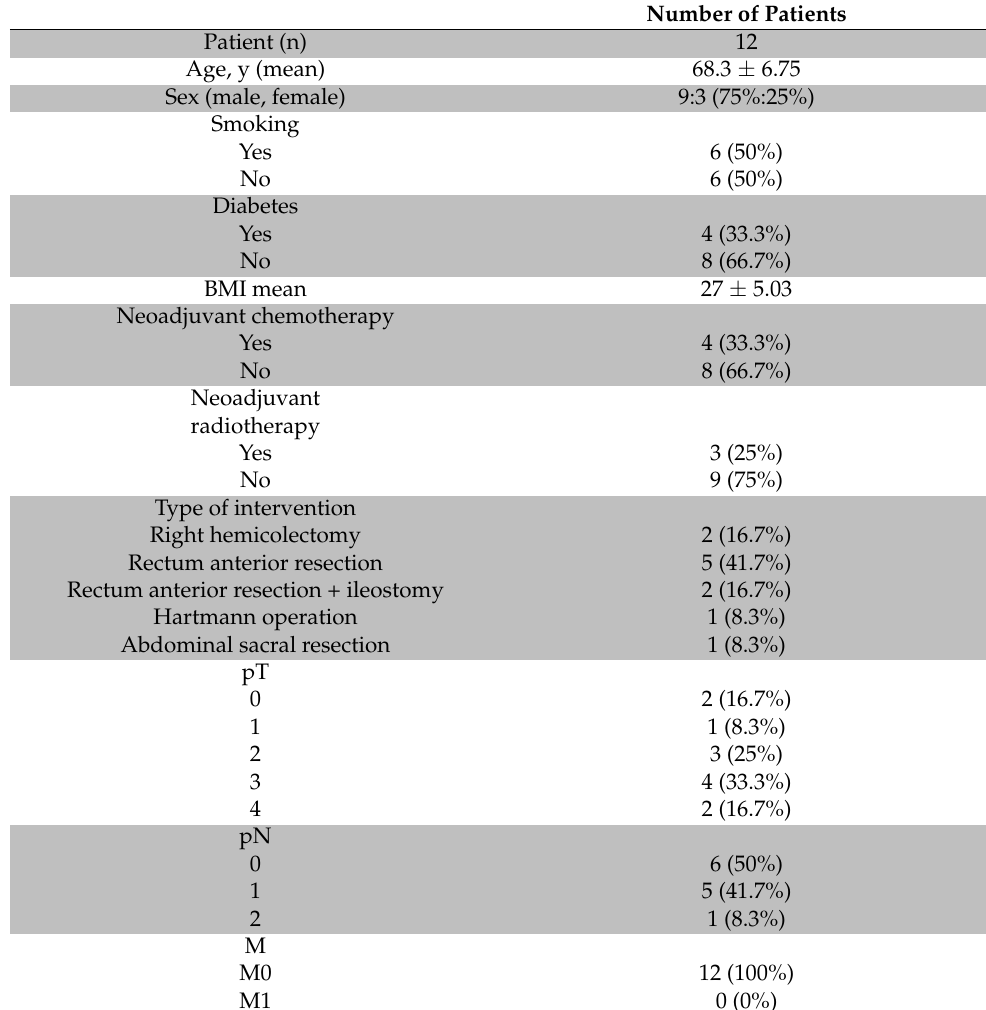
Table 1. Clinicopathological data of